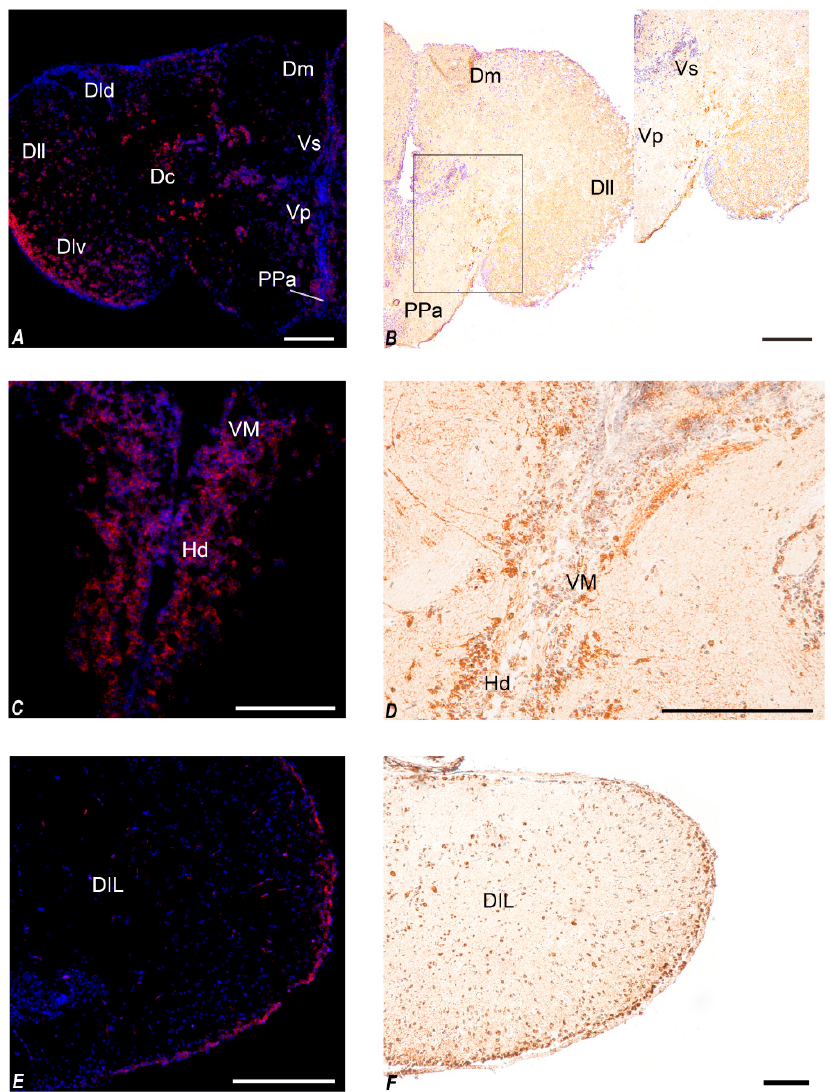
Figure 4. Transversal section showing localization of NUCB2B mRNA and Nesf-1 protein in the young brain of N. furzeri . ( A ) NUCB2B expressing neurons in Dc, Dld, Dll, Dlv, Dm, PPa, Vp, and Vs; ( B ) Nesf-1 immunoreactivity (ir) in neurons of Dm, DIL, PPa, Vp, and Vs; ( C ) NUCB2B expressing neurons in VM and Hd; ( D ) Nesf-1 ir in neurons of VM and Hd; ( E ) NUCB2B expressing neurons in DIL; ( F ) Nesf-1 ir in neurons of DIL. Scale bars: A-B-F 100 µm; C-E 200 µm; D 300 µm.